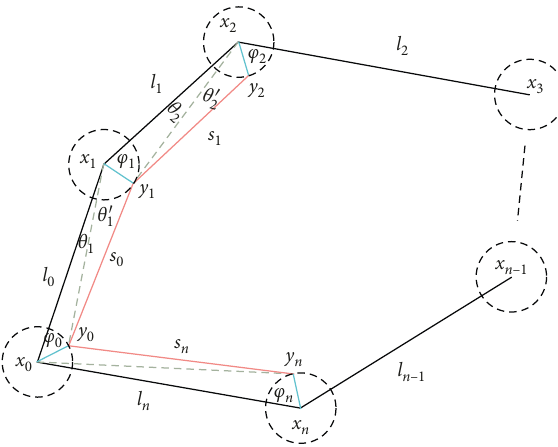
Figure 5: Angular bisection line to solve best stop point